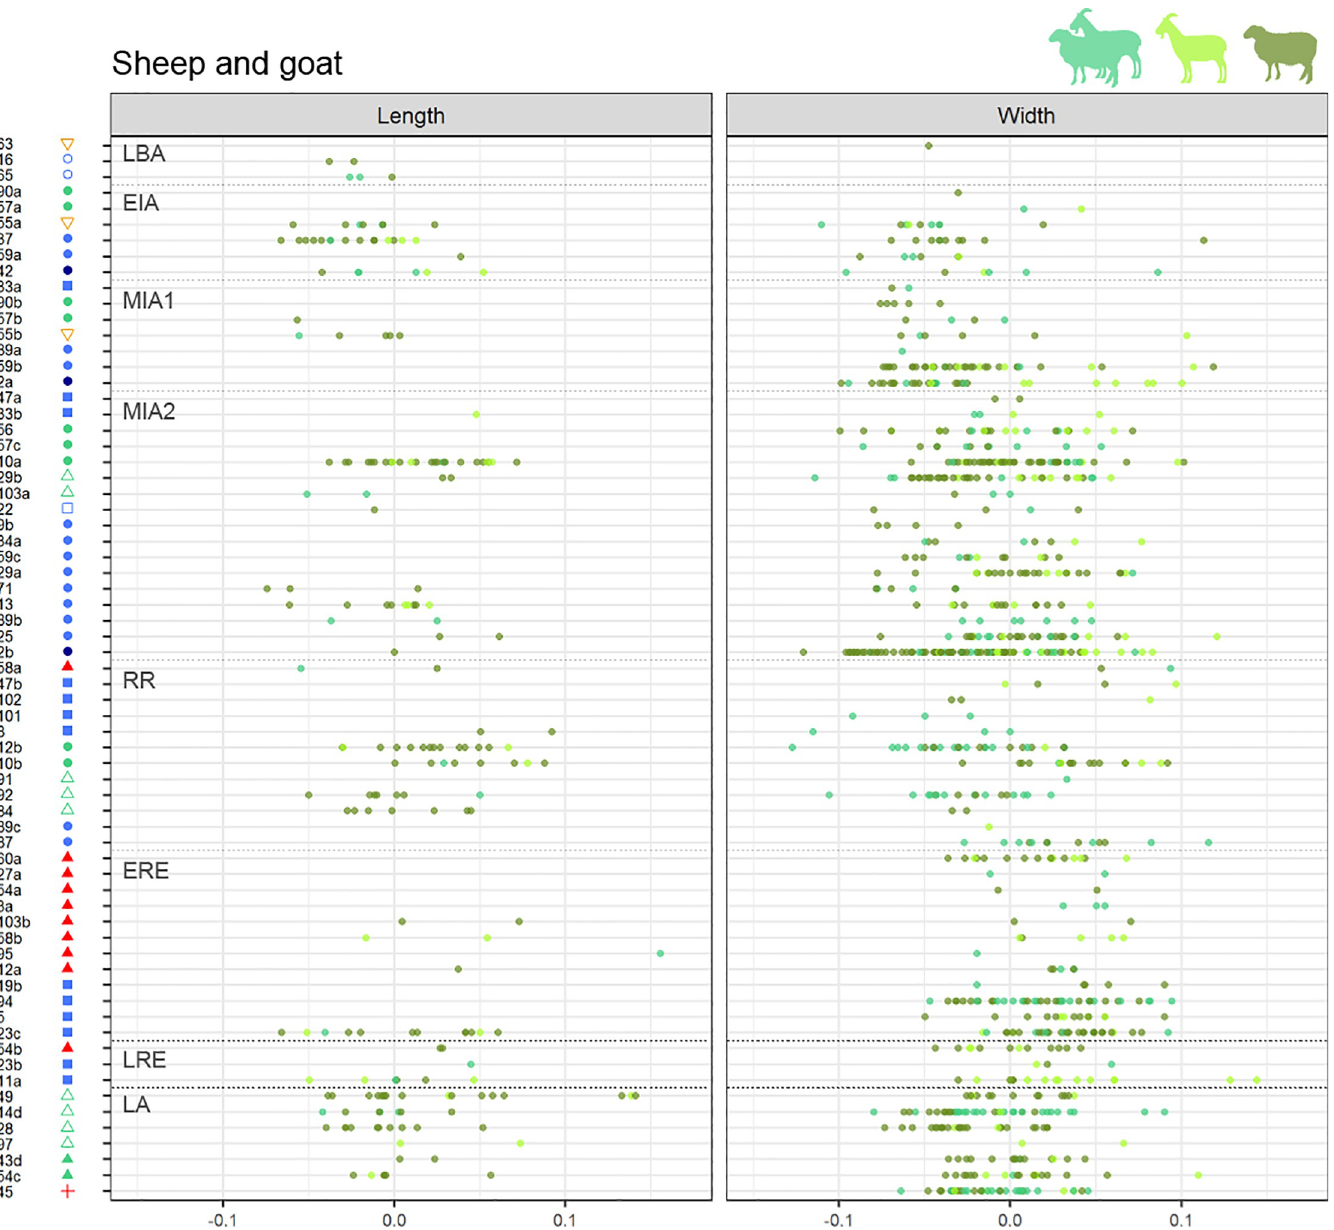
Fig 10. Sheep and goats LSI length and width values by assemblages ordered by periods. (from top to bottom, LBA: Late Bronze Age, EIA: Early Iron Age, MIA1: Middle Iron Age 1, MIA2: Middle Iron Age 2, RR: Roman Republic, ERE: Early Roman Empire, LRE: Late Roman Empire, LA: Late Antiquity). Left column shows length LSI values, right column shows width LSI values. Assemblages’ symbols refer to their type (see Fig